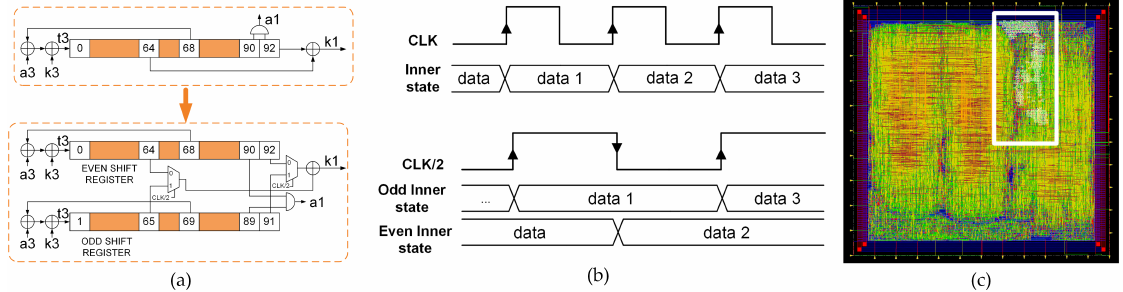
Figure 4. ( a ) Schematic representation of the power reduction technique for Trivium. ( b ) Waveforms for standard and low power Trivium. ( c ) Layout of the ASIC highlighting the location of the low power